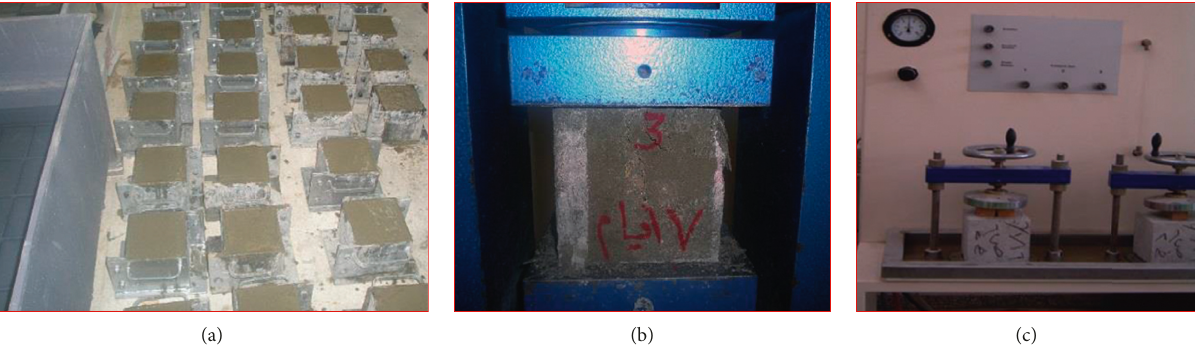
Figure 2: Photos of (a) the cubic concrete specimens, (b) the compression test, and (c) the water permeability set-up. Table 1: Chemical composition of the ingredients used in the concrete mix. Chemical composition (mass,